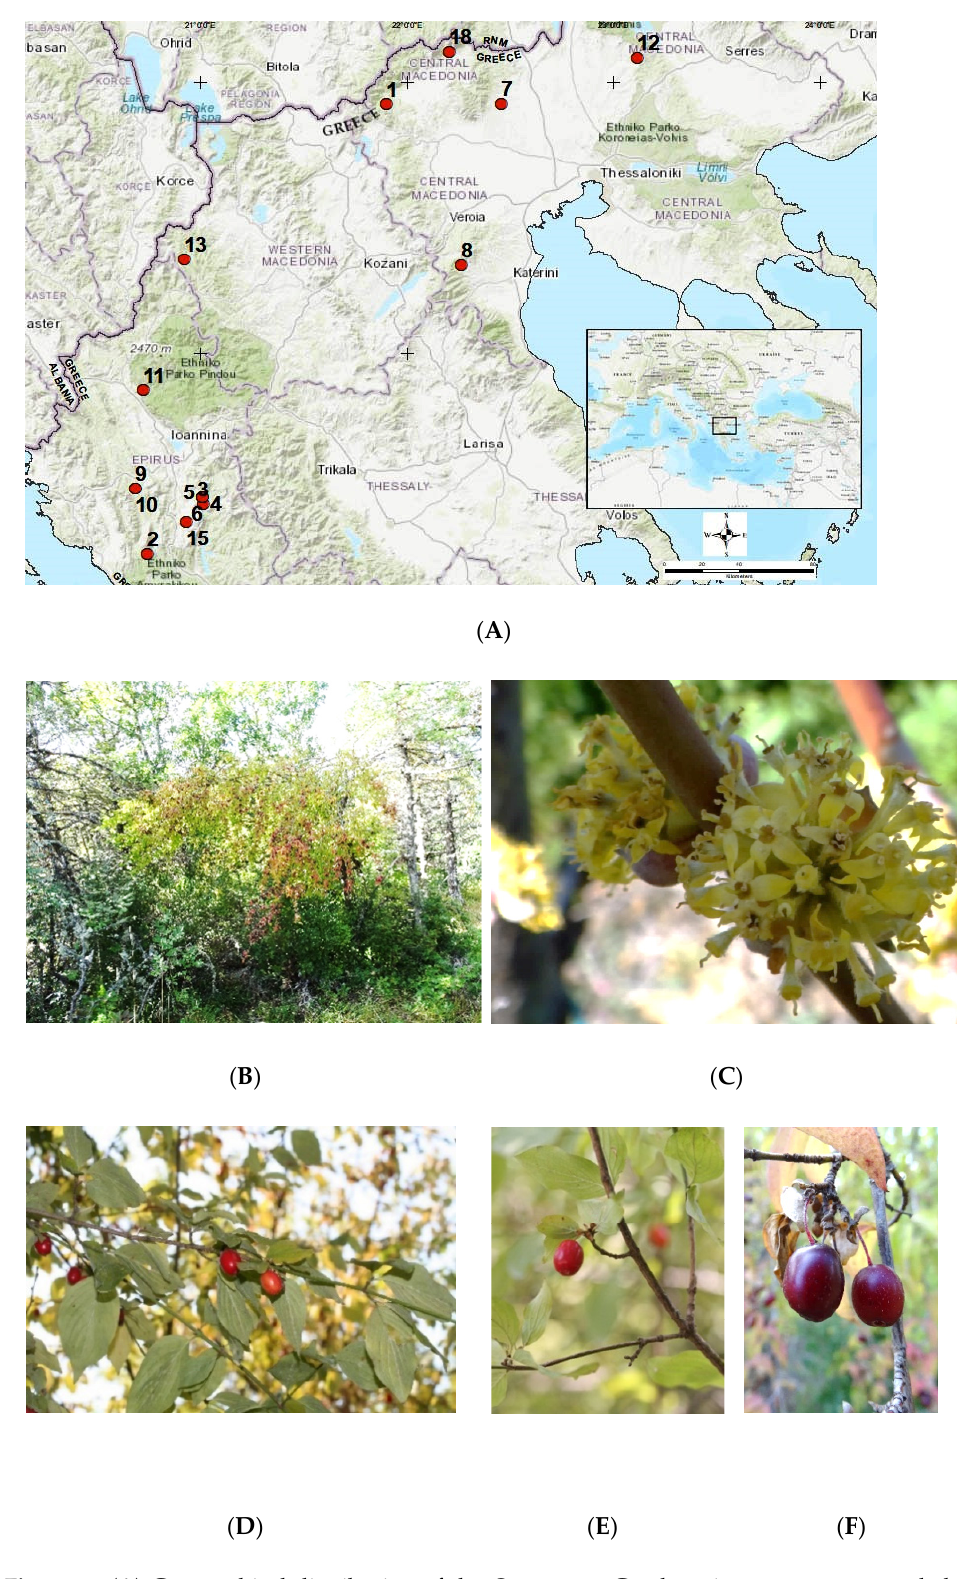
Figure 3. ( A ) Geographical distribution of the Cornus mas Greek native genotypes sampled for taxonomic identification, DNA barcoding, phytochemical assessment, and asexual propagation trials. ( B ) Typical habit of wild-growing individuals; morphology of flowers ( C ) leaves and fruits ( D ) in early ( E ) and full ripening ( F